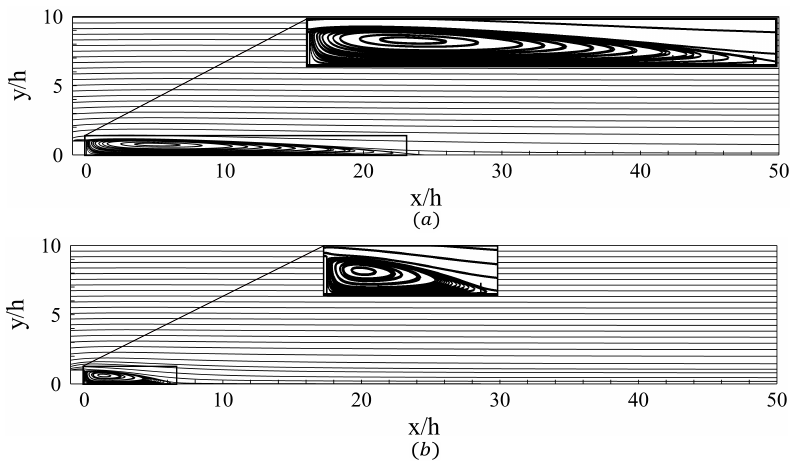
Figure 4. Streamline plot of the ( a ) Newtonian fluid and ( b ) viscoelastic fluid flow past a roughness element of bar height h / D = 0.05.